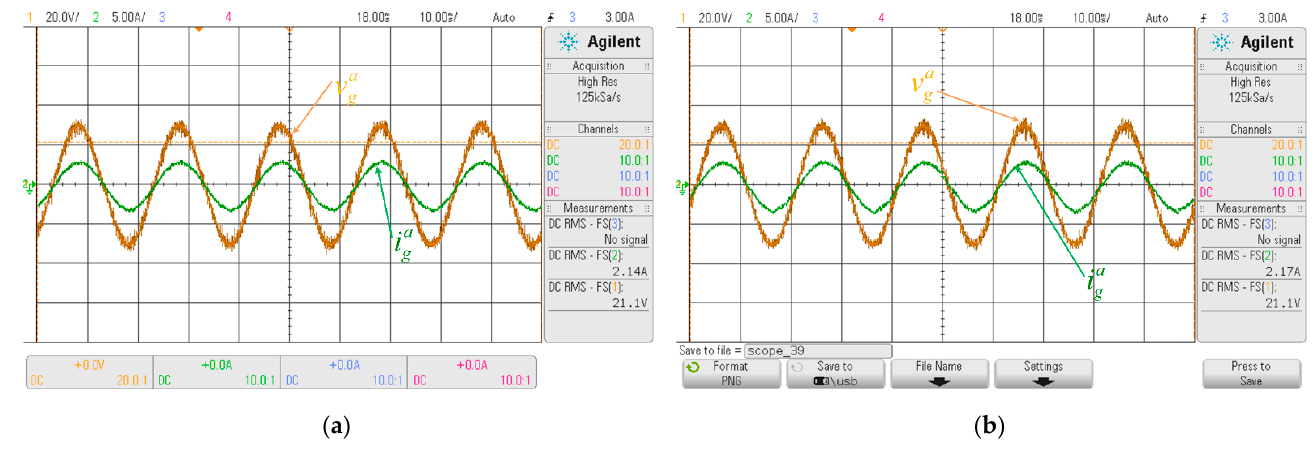
Figure 9. Input voltage and input current multicell AFE rectifier phase a . ( a ) for k sw = 0.00, ( b ) for k sw = 0.12.